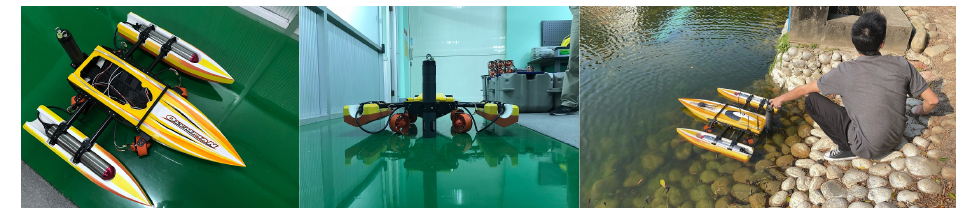
Figure 10. Mini ship tool.